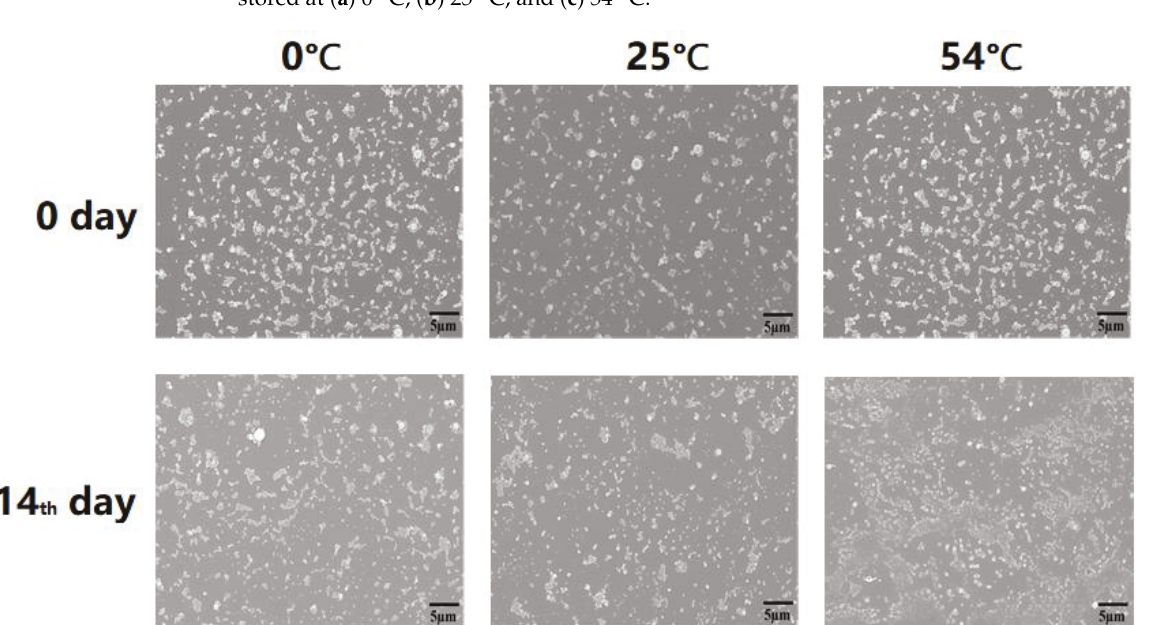
Figure 7. Particle sizes and polydispersity indices (PDIs) of double-loaded nano-microcapsules